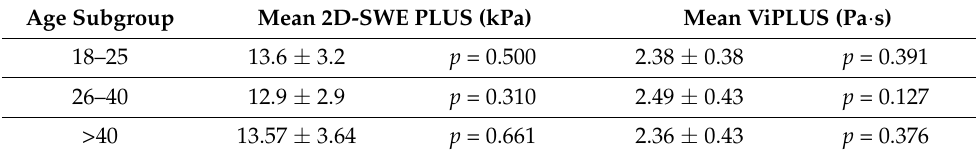
Table 3. Normal thyroid tissue values for 2D SWE and ViPLUS according to age subgroups.